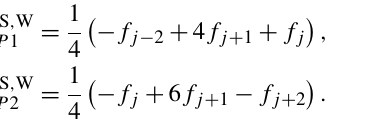
since they are analogous orientations. For the south ( S ) and west ( W ) edges, similar expressions are